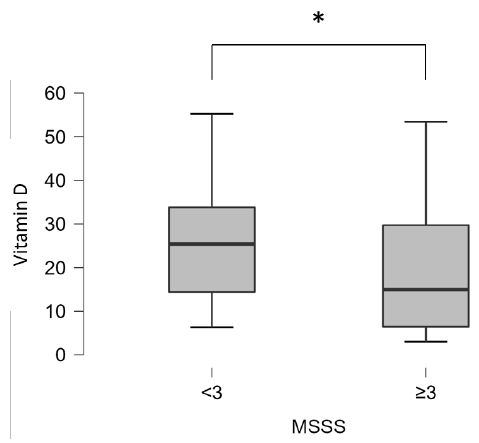
Figure 4. 25(OH)D 3 levels in patients with a mild form (MSSS score < 3; 41 subjects) and patients with moderate to severe forms (MSSS ≥ 3; 32 subjects) of MS; 25th percentile, median and 75th percentile are reported on the dot plot (black bars). The two groups have significantly different 25(OH)D 3 levels (Mann–Whitney test, * p = 0.048). Since it is known that 25(OH)D 3 can induce VDR expression [23], the total VDR